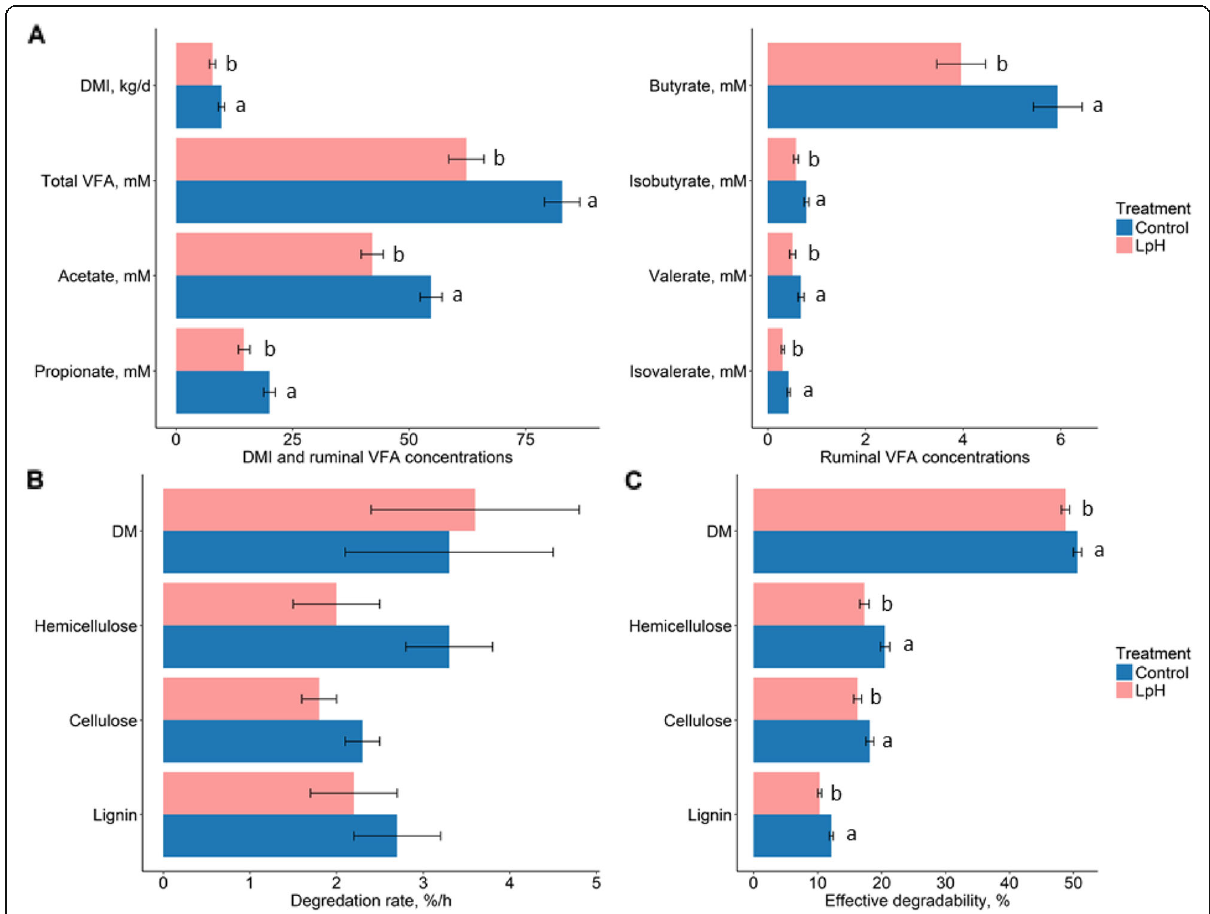
Fig. 6 Effects of ruminal pH on DMI, fiber degradation, and ruminal volatile fatty acid concentrations. Different characters indicate significantly different means between normal and low pH